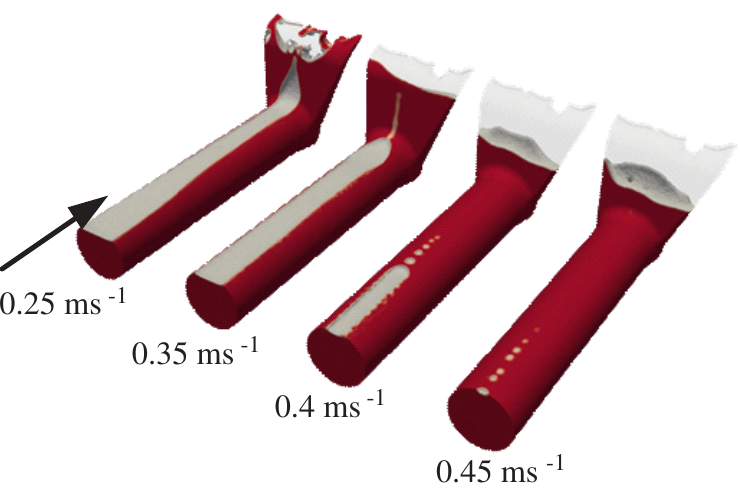
Figure 8. The fraction occupied by air after the melt front has propagated into the ingate of the die (at top right in each case). The arrow indicates the direction of motion of the plunger.